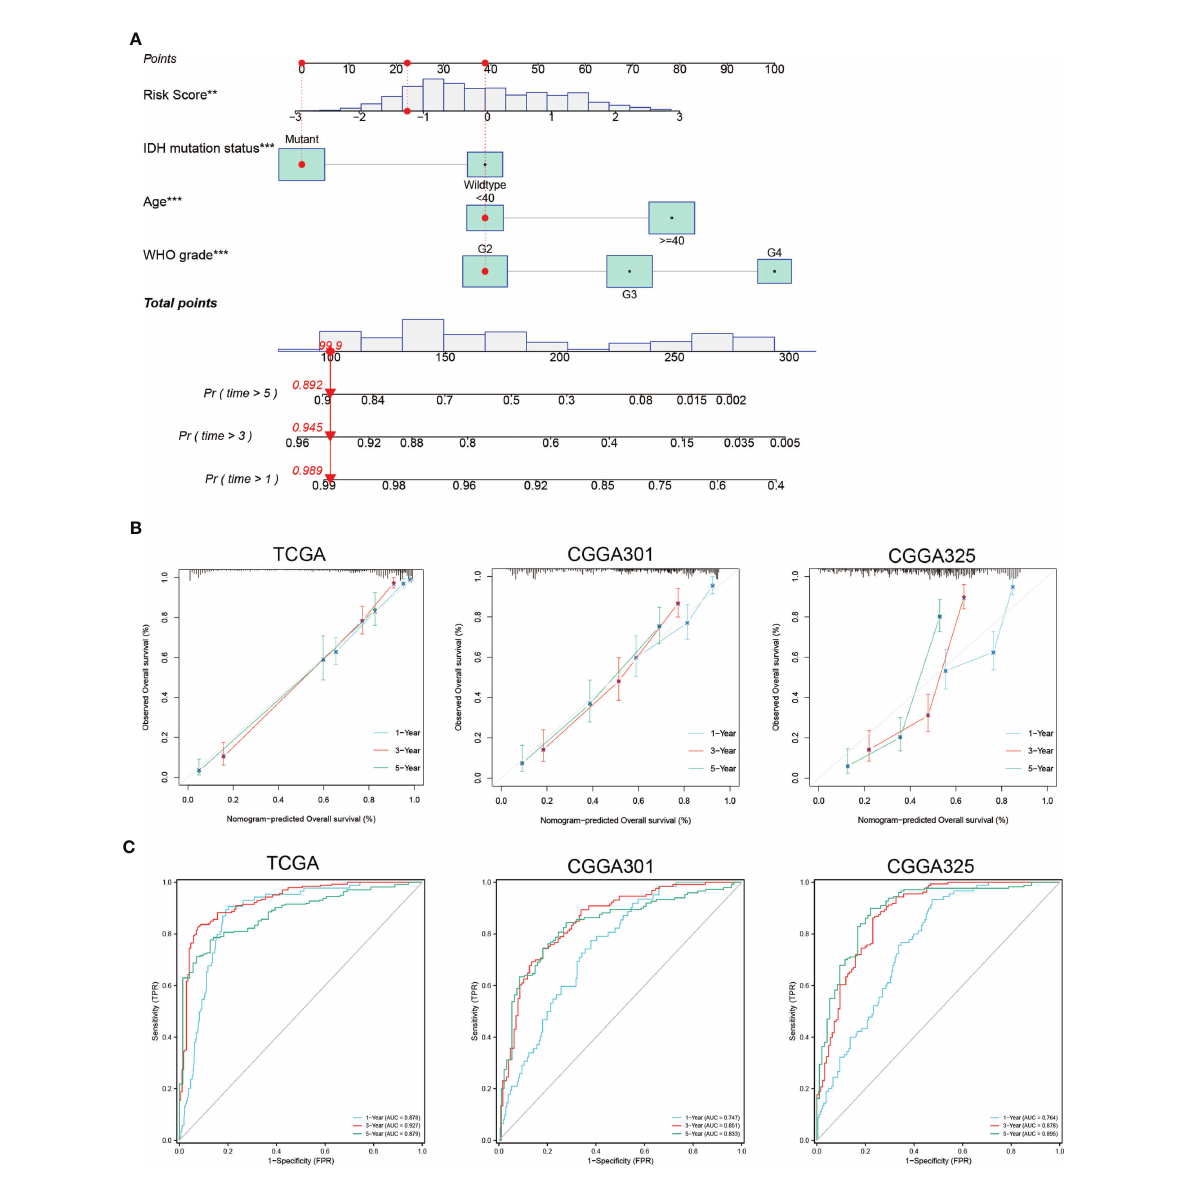
FIGURE 4 Construction and validation of nomogram based on independent prognostic factors of glioma. (A) Prognostic nomogram to predict the 1-, 3-, and 5-year OS of glioma patients. Red dots represent one case from the TCGA training set. (B) The 1-, 3-, and 5-year calibration curves for the nomogram in the TCGA and CGGA cohorts. The x-axis and y-axis represent nomogram predicted and actual survival, respectively. The 45- degree gray line represents perfect calibration. (C) The 1-, 3-, and 5-year ROC curves for the nomogram in the TCGA and CGGA cohorts. **p < 0.01; ***p <